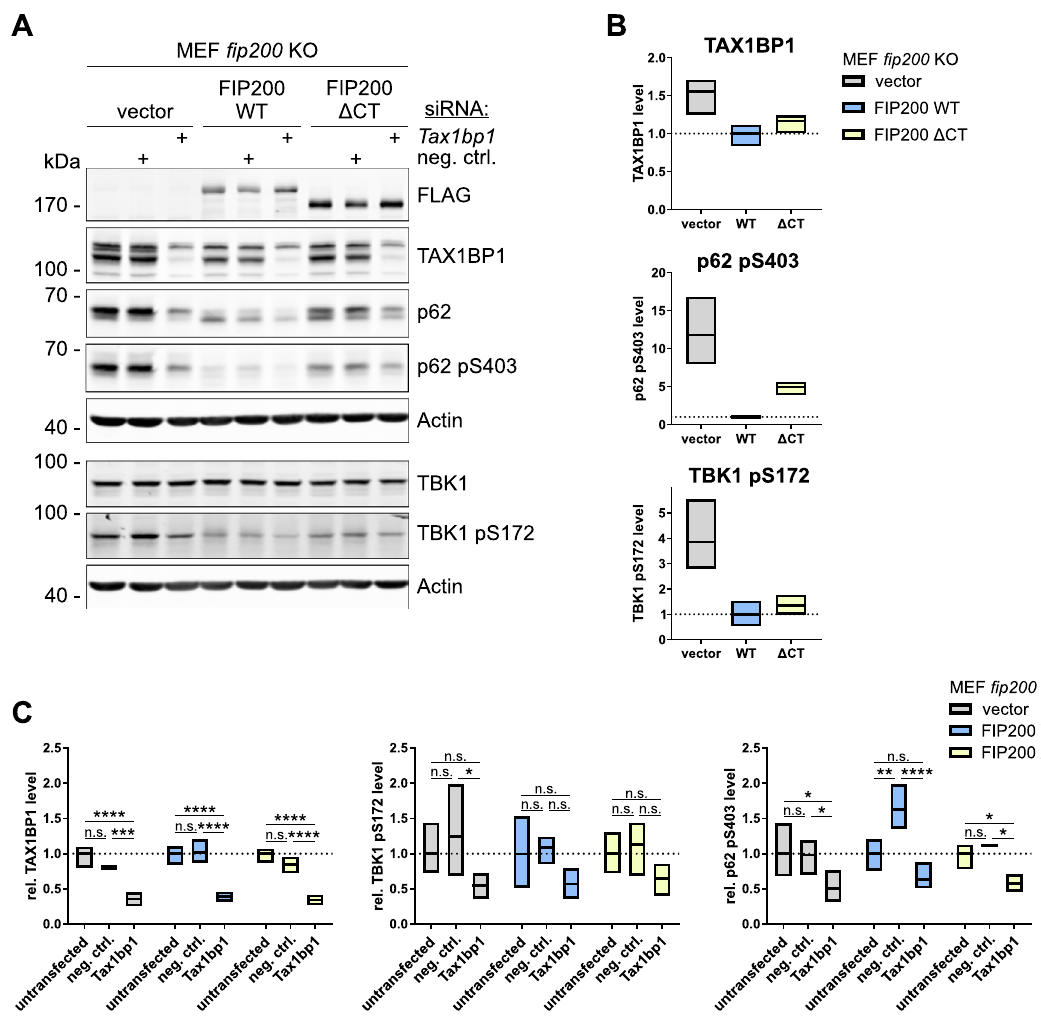
Figure 4. Aberrant TBK1 accumulation depends on TAX1BP1. ( A ) fip200 KO, FIP200 WT, and FIP200 ΔCT MEFs were transfected with either 20 nM negative control siRNA or 20 nM Tax1bp1 siRNA for 72 h, and cleared cellular lysates were immunoblotted for the indicated proteins. The FIP200 cDNAs used for reconstitution of fip200 KO MEFs encoded an N-terminal FLAG peptide. The densities of the bands on immunoblots from three independent experiments were quantified and normalized to those of Actin. The full-length blots are presented in Figure S7. ( B ) To compare basal expression levels between the cell lines used, the normalized densities of the untransfected samples were normalized to the signal of FIP200 WT MEFs. ( C ) To analyze the influence of siRNA transfection, the normalized densities of all samples of each cell line were normalized to that of the corresponding untransfected sample. Only the relative levels of TAX1BP1, TBK1 pS172, and SQSTM1/p62 pS403 are shown. The boxes represent the highest and the lowest value, while the centerline shows the mean. Two-way ANOVA with uncorrected Fisher’s LSD test was used to determine differences between treatments. n.s. = not significant; *p < 0.05; **p < 0.01; ***p < 0.001; ****p <